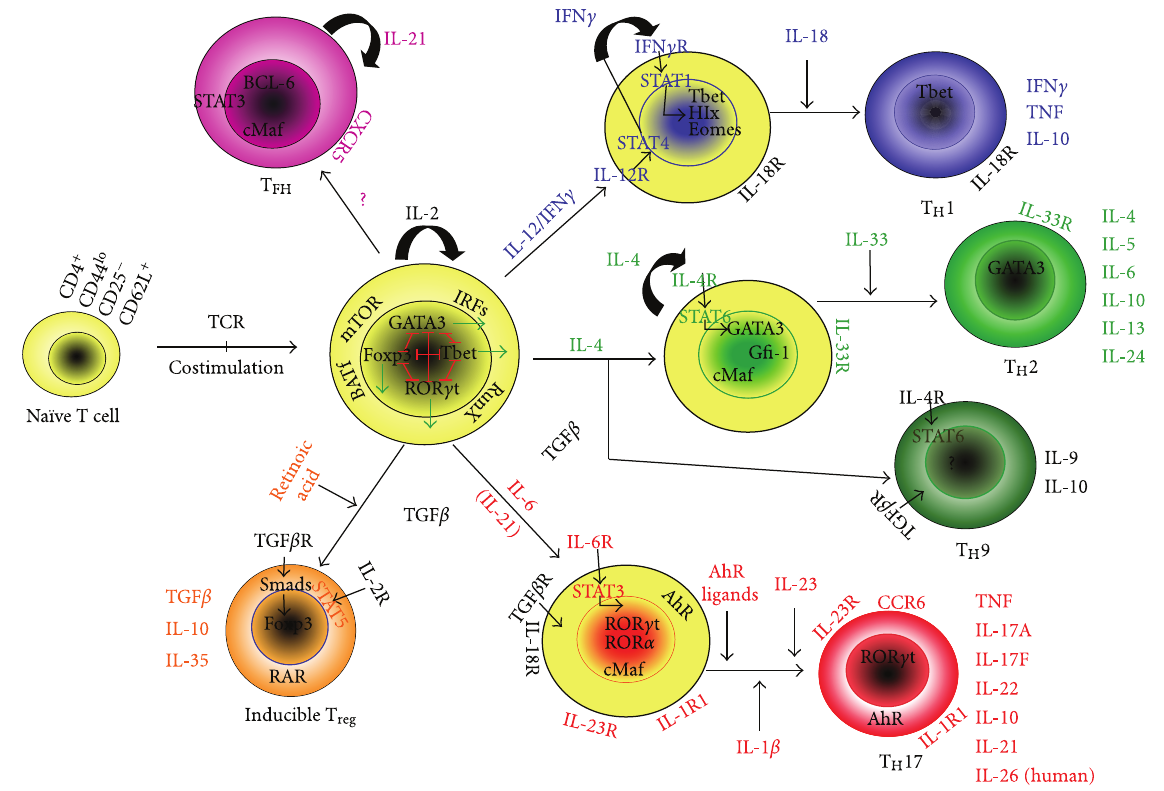
Figure 1: Current schedule of T-helper-cell di ff erentiation. When na¨ıve CD4 + TCR αβ + T lymphocytes, classified by their low expression of CD44, absence of CD25, and high levels of CD62L, encounter their cognate antigens, they can di ff erentiate into several previously identified e ff ector subsets. It is likely that several “master” transcription factors, individually required for T-cell di ff erentiation towards one of the end e ff ector stages, are initially expressed upon engagement of the TCR with costimulatory receptors. Each transcription factor drives a specific set of genes required for lineage commitment and the expression of signature cytokines and negatively a ff ects alternative pathways. However, the local microenvironment is the driving force that determines the outcome of the di ff erentiation course. Th1 cells are established in the presence of IFN γ and IL12 and signaling via STAT1 and STAT4, resulting in the expression of the master transcription factor T bet. Th2 cells depend on IL4 and STAT6 for the increased expression of GATA3, whereas the simultaneous presence of TGF β results in the development of Th9 cells, utilizing an undefined master transcription factor. The presence of TGF β , with IL2 signaling via STAT5, is known to generate, at least in vitro, inducible Treg, which utilize FOXP3 like those Treg generated in the thymus. Again, it is TGF β in combination with IL6 signaling via STAT3 that drives the expression of ROR γ t, resulting in the di ff erentiation of Th17 cells. However, the initiation of the developmental program of these T helper subsets may not be completed in the presence of only these driving cytokines. Several additional factors may be required for their subsequent functional maturation or may be responsible for the fine tuning of their e ff ector phases. Several of these factors are indicated, together with the characteristic cytokine profiles of each subset (adapted from